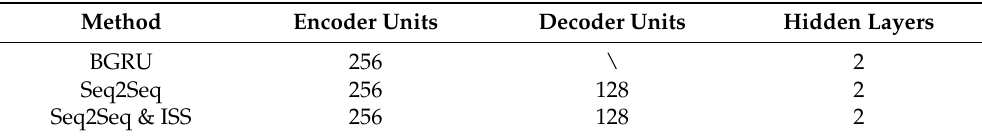
Table 1. The structural parameters of networks.